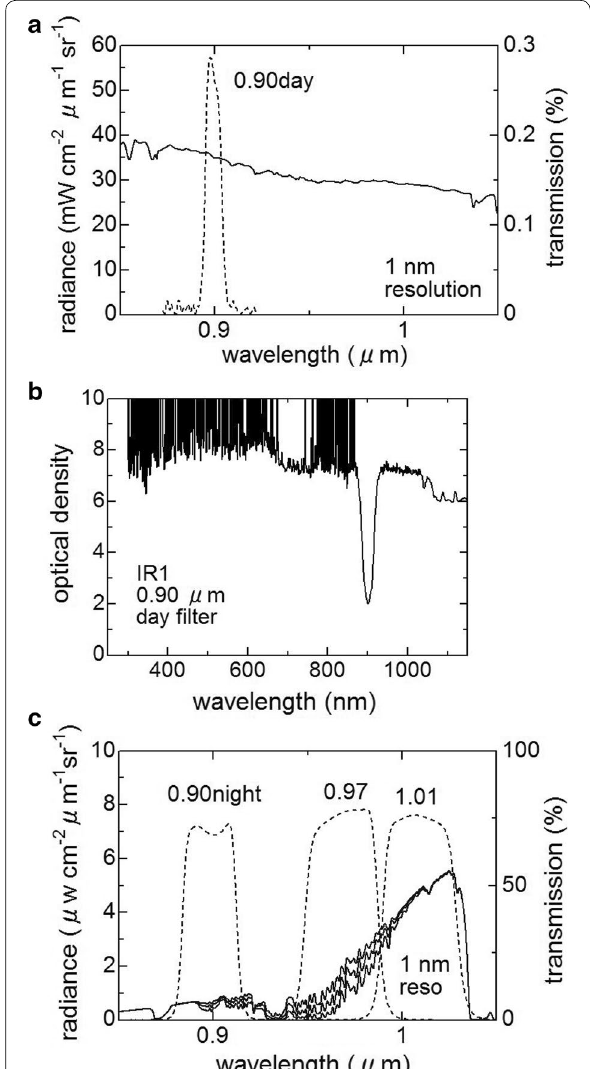
Fig. 1 a Dayside 0.90‑μm filter transmission (dashed curve: revised from Iwagami et al. 2011) with an expected scattered solar spectrum (solid curve) showing little interference due to Venus atmospheric gases. The peak transmission of the filter is as small as 0.29% because of one common detector and electronics for dayside and nightside. b 0.90‑μm dayside filter blocking ability (after BARR Co.). Blocking is effective at 300–1150 nm except in the pass band around 900 nm showing optical density (OD) of seven or more. Note that transmis‑ sion 10 − OD . c Nightside 0.90‑, 0.97‑ and 1.01‑μm filter transmissions = (dashed curves: revised from Iwagami et al. 2011) with expected Venus thermal emission spectra (solid curves) with a 1‑nm resolu‑ tion. The three spectra are for H 2 O surface abundances of 15, 30 and 60